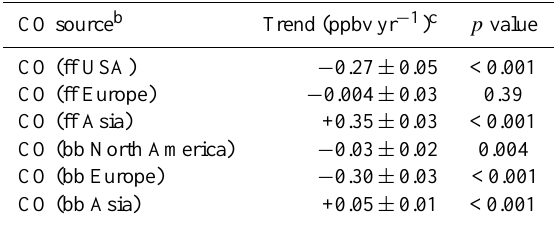
Table 4. Trends in contributions to CO at PMO from various regions and sources a